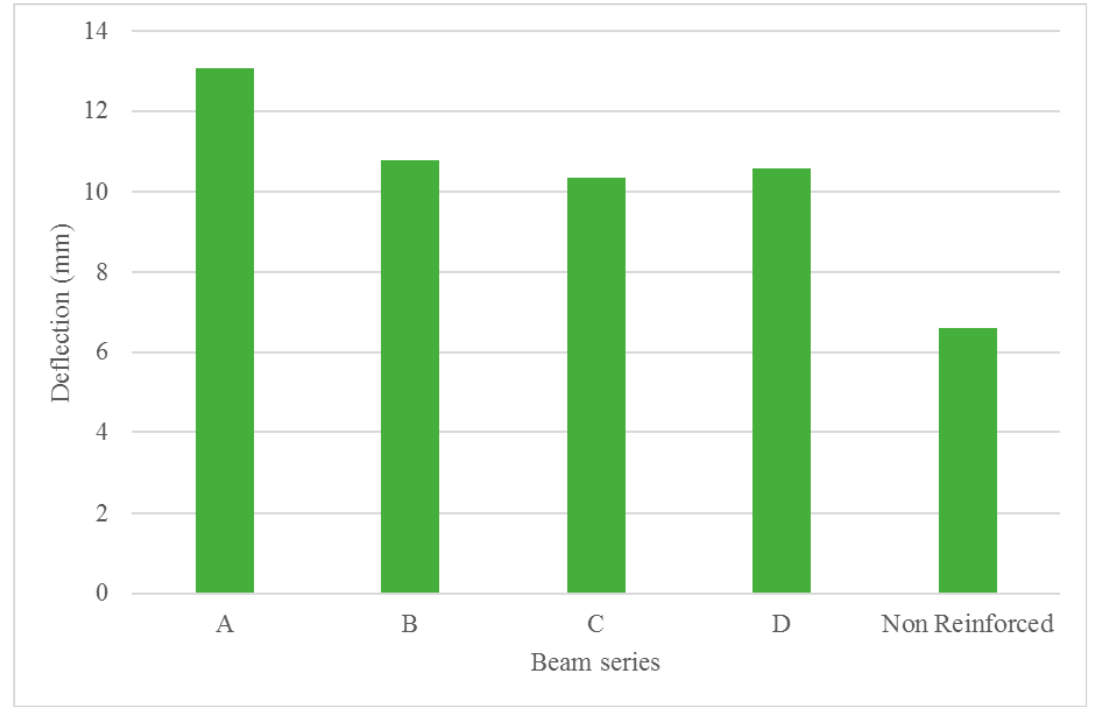
Figure 18. Maximum mid-span deflection of the beams investigated in this study.